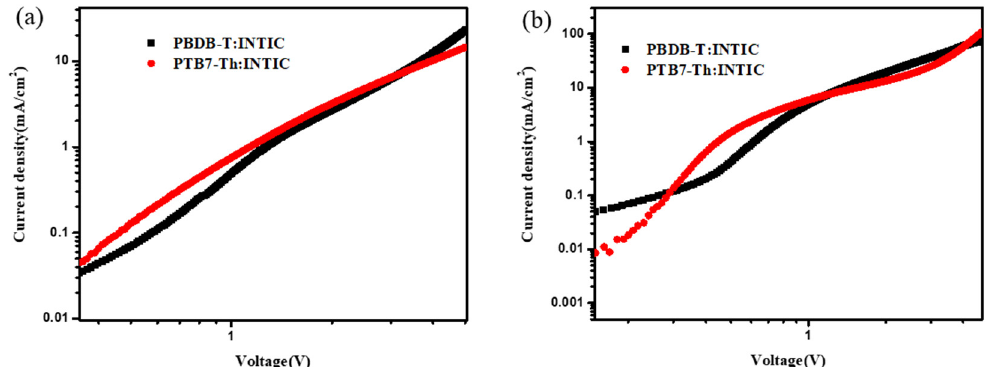
Figure 7. ( a ) J-V curves of ITO / ZnO / Active Layer / Al to measure the electron mobility of PTB7-